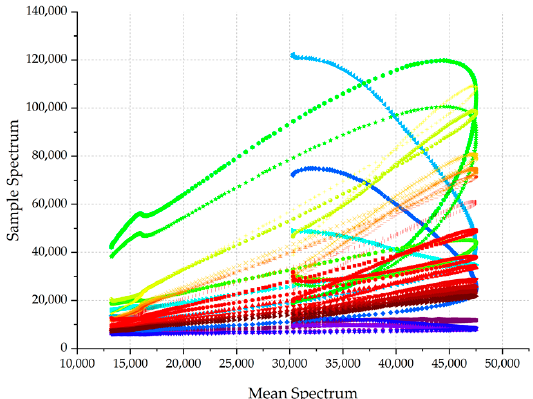
Figure 6. Scatter effects plot for fluorescence spectral data obtained in chromatography.